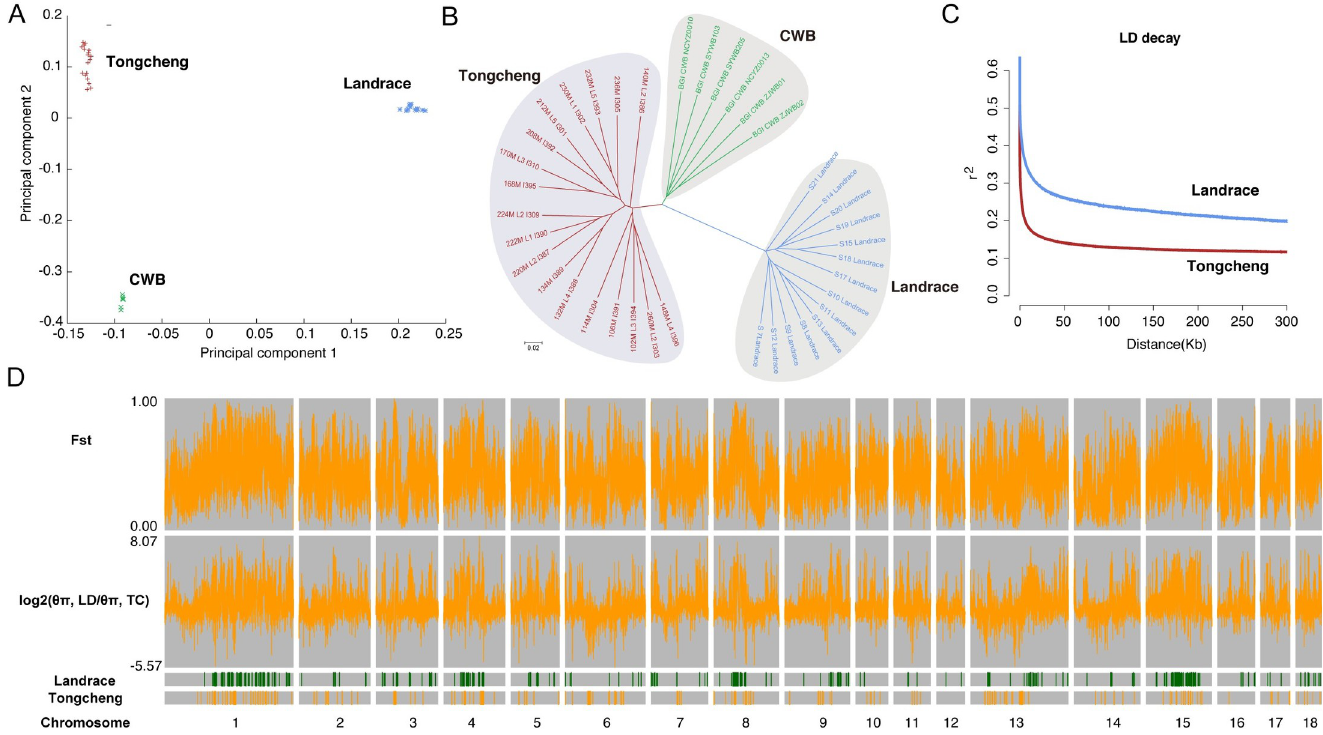
Fig 5. Genetic diversity between Landrace and Tongcheng pigs. ( A ) Principal components analysis (PCA) of 38 pigs from Tongcheng pigs, Landrace pig and Chinese wild boars. ( B ) A neighbor-joining phylogenetic tree constructed using SNP identified in the 38 pigs. ( C ) Linkage disequilibrium patterns of Landrace and Tongcheng pigs. ( D ) The distribution of the genome-wide F ST (top), log 2 ( θ π , Landrace / θ π , Tongcheng ) values (middle) and selected regions (bottom) in Landrace and Tongcheng pigs across 18 autosomes.